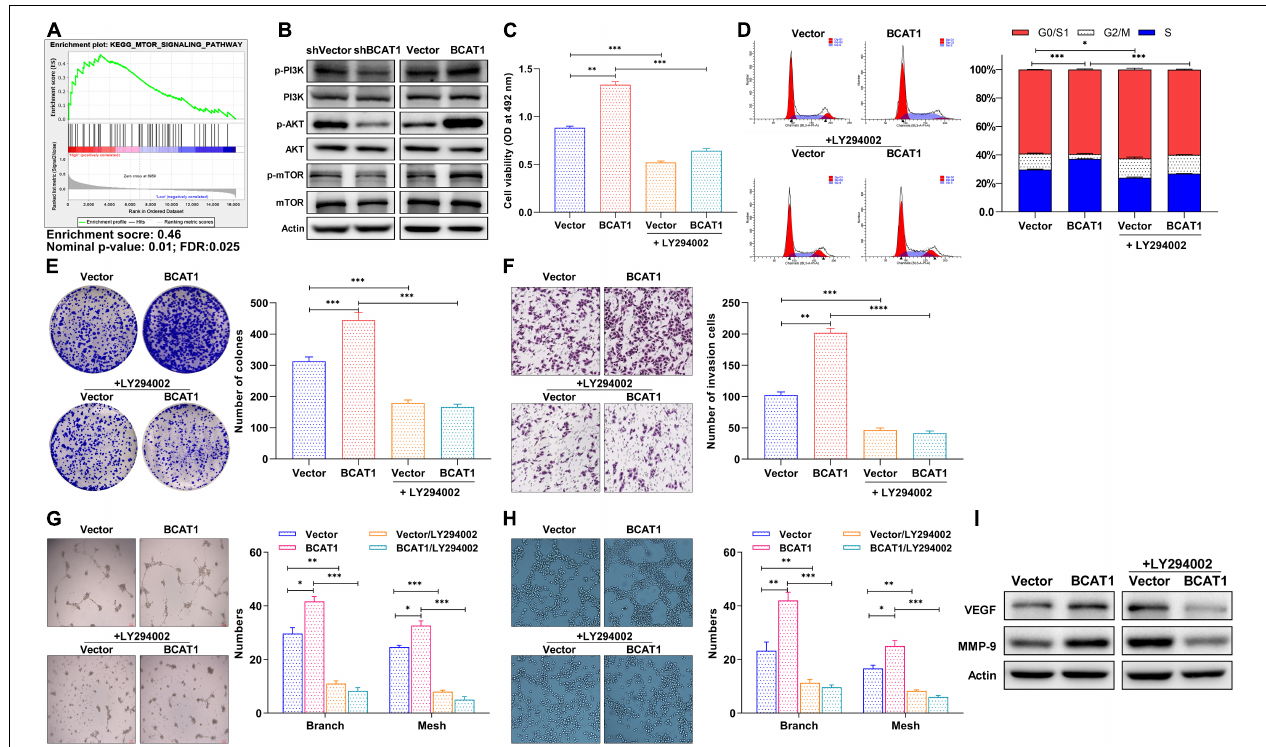
FIGURE 4 | BCAT1 activates PI3K/AKT/mTOR signaling to promote proliferation and angiogenesis of GC cells in vitro. (A) GSEA plot showing positive correlation between BCAT1 and mTOR pathways. (B) Western blot showing expression of proteins in PI3K/AKT/mTOR signaling in transfected cells. BCAT1-overexpressing cells or NC cells were treated with LY294002 (10 µ M). (C) MTT assay, (D) flow cytometric analysis, (E) colony formation assay, (F) Transwell invasion assay, and (G,H) HUVEC tube formation assay were performed to detect proliferation, cell cycle, invasion, and angiogenesis ability after LY294002 treatment. (I) Western blot for MMP-9 (invasion marker) and VEGF (angiogenesis marker) after LY294002 treatment. * p < 0.05, ** p < 0.01, *** p < 0.001. Data are expressed as mean ± SEM of three independent